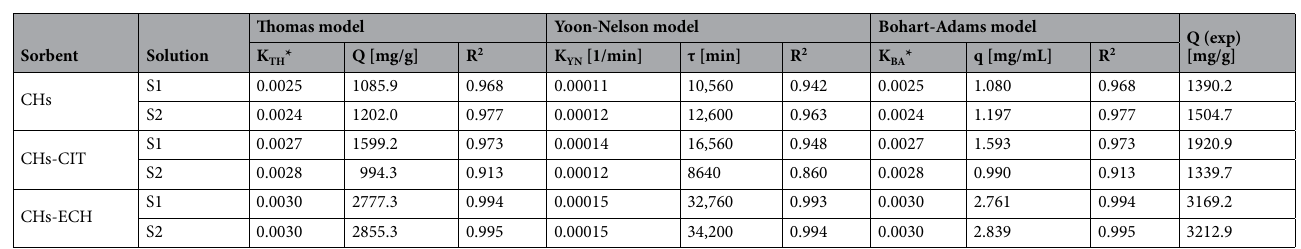
Table 3. Constants determined from Thomas, Yoon–Nelson, and Bohart-Adams sorption models. *Unit [mL/ (min